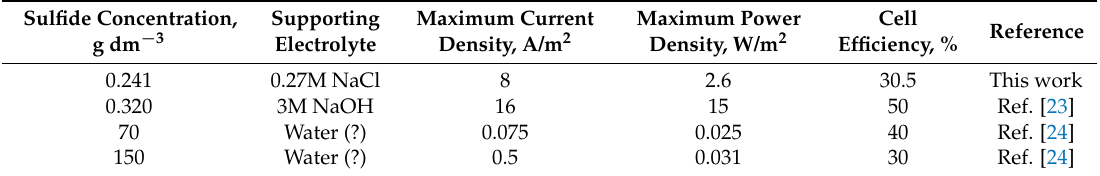
Table 4. Comparison of the measured current and power densities to referent